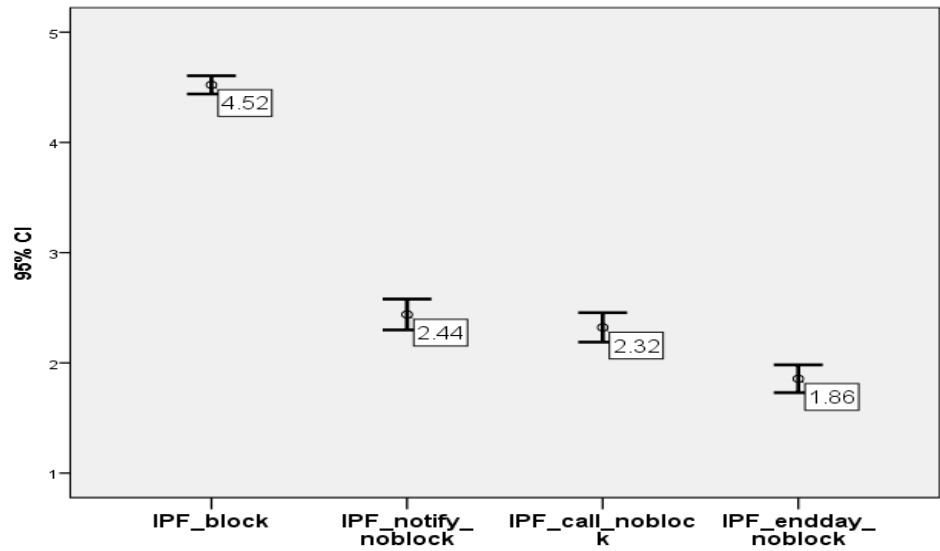
Figure 4. Level of control of individuals and possible reactions to fraud detection. Source: Authors’ processing in SPSS 24.